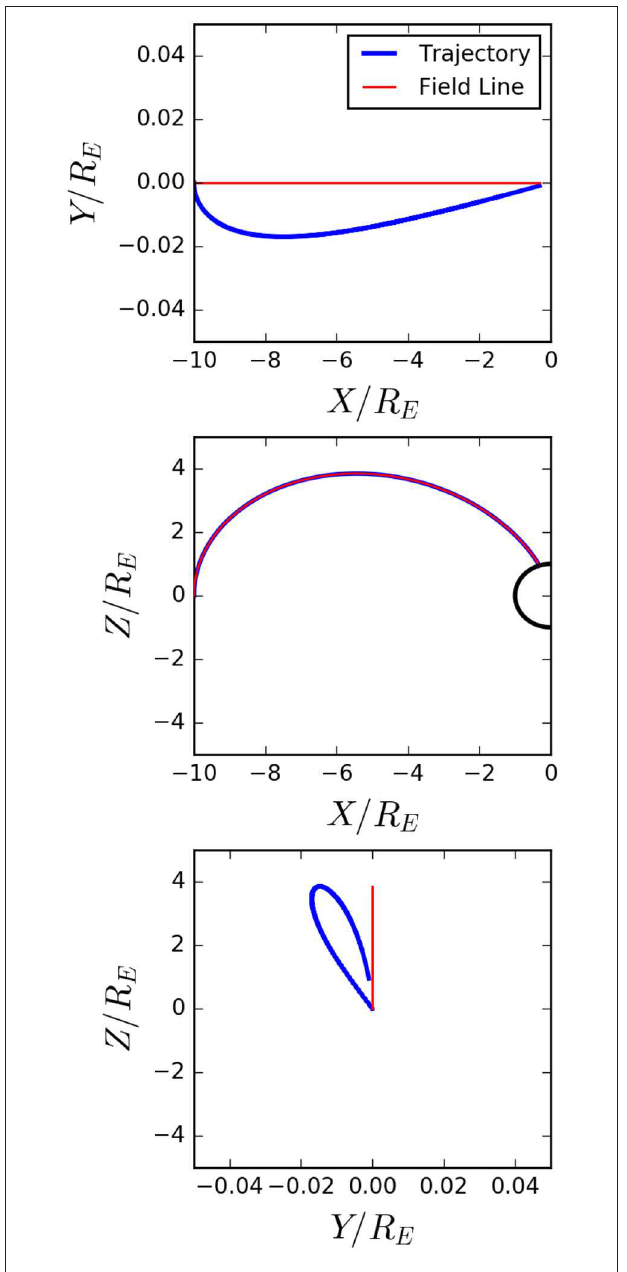
FIGURE 4 | Trajectory of a single electron (blue) injected from dipole field line (red).